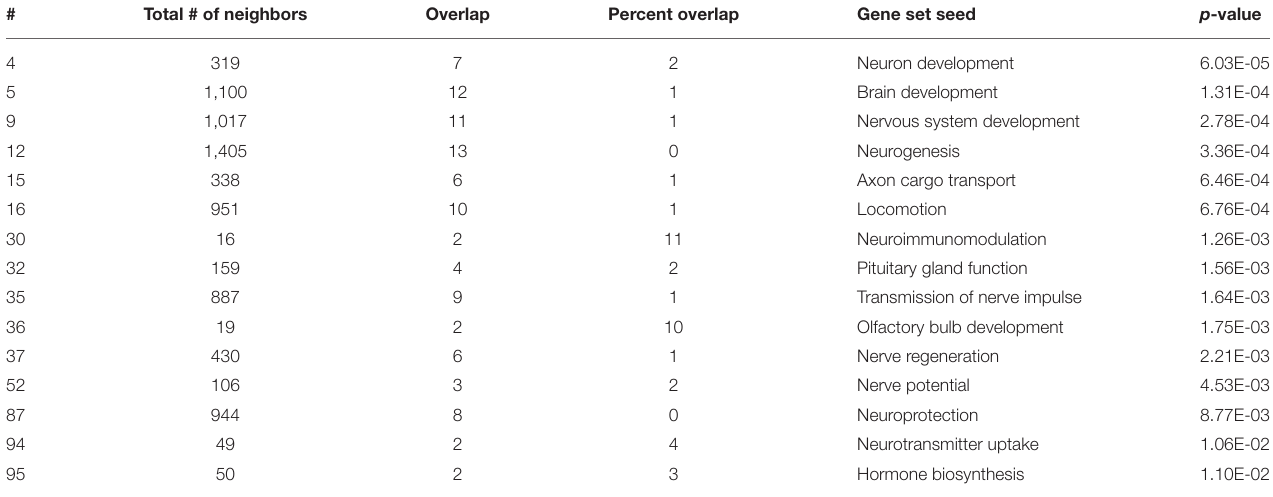
TABLE 4 | Selected subnetwork enrichment pathways for the hypothalamus.